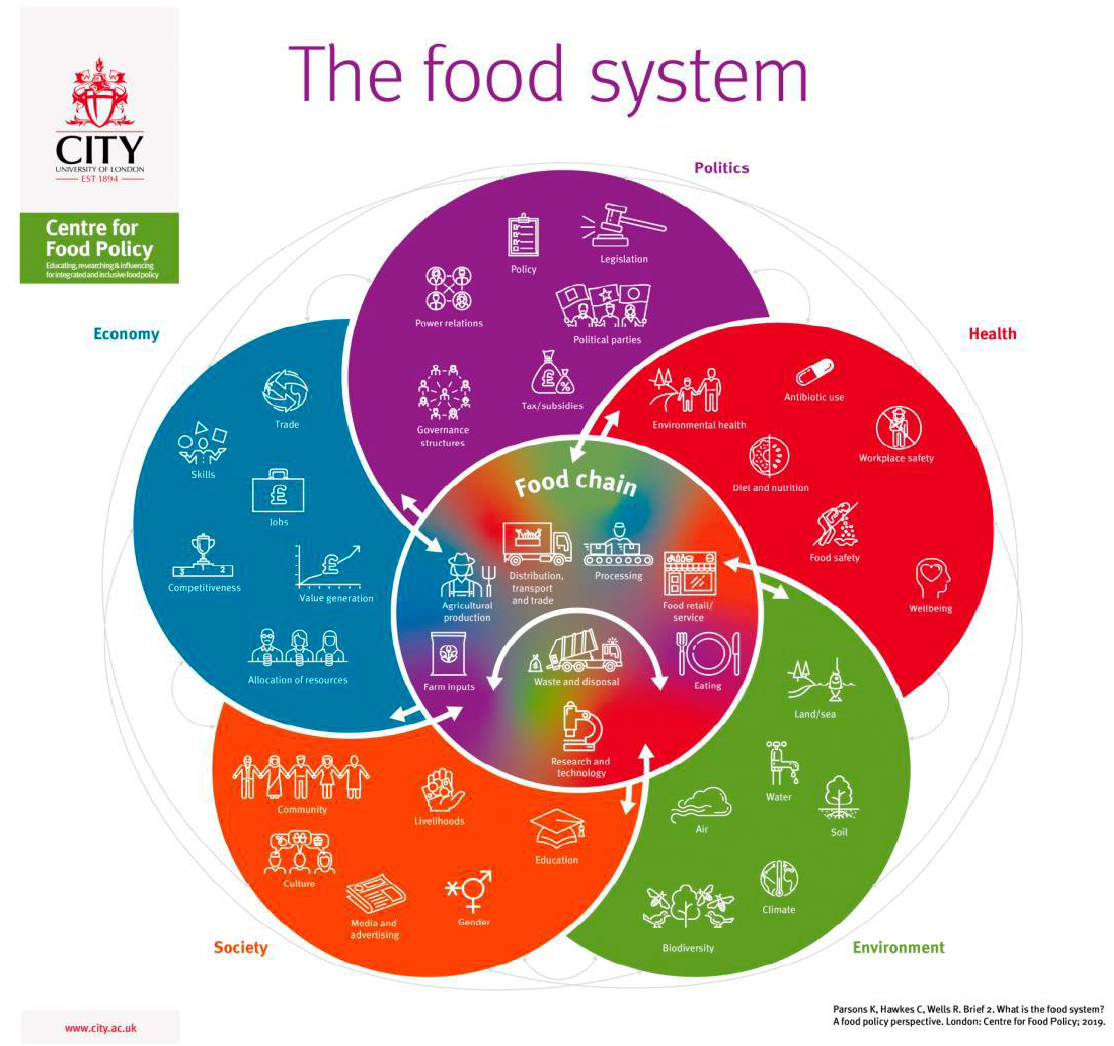
Figure A1. The food system. Source: [4].